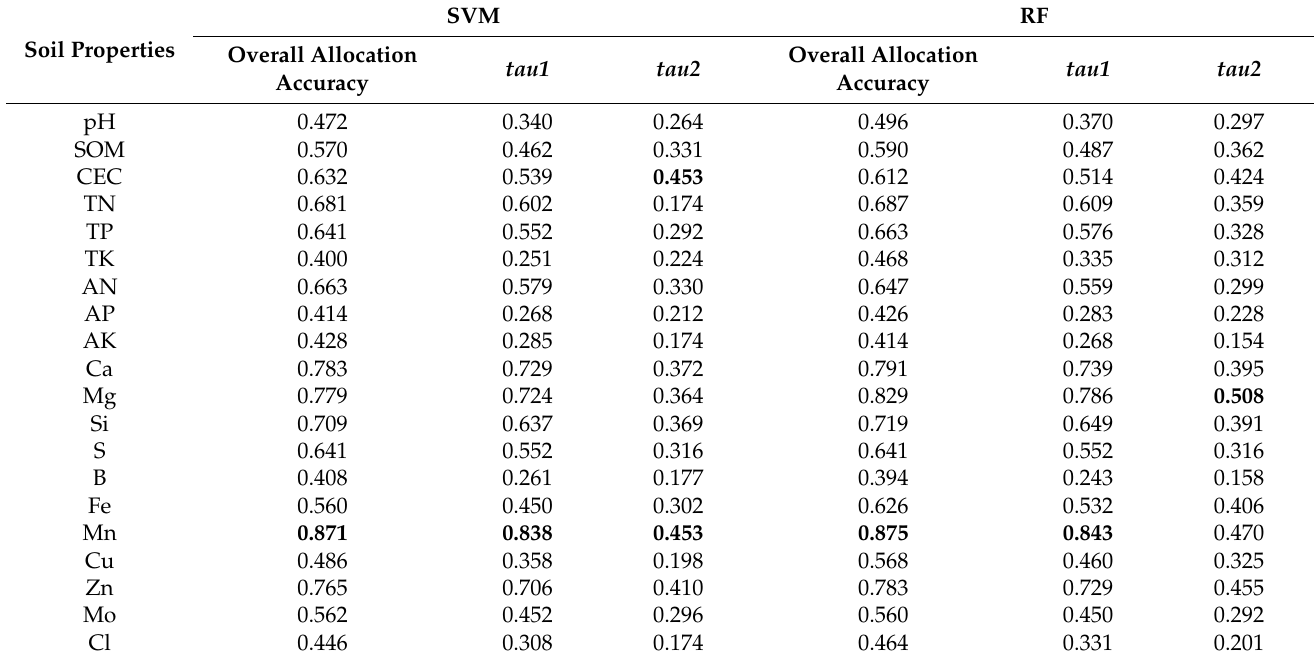
Table 11. Allocation accuracy of soil fertility classes directly from spectra (five fertility classes).